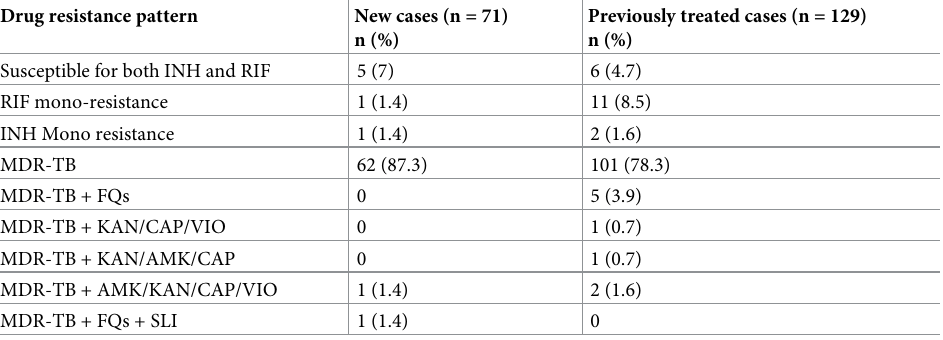
Table 2. Resistance to anti-TB drugs among new and previously treated RR/MDR-TB cases (N = 200). Drug resistance